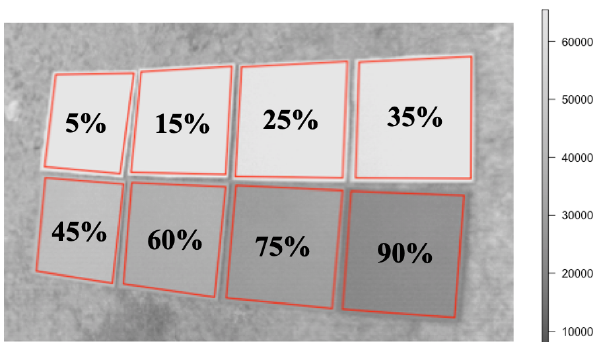
Figure 3. Surface reflectance of the grey gradient calibration panel measured in the different multispectral bands.